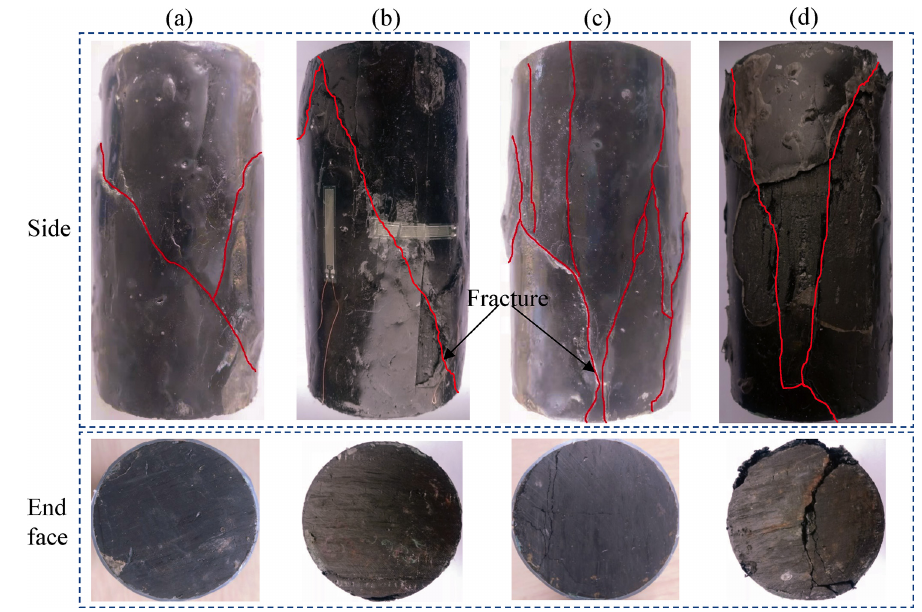
Figure 12. Fracture shapes of specimens. (a, b) Unfrozen specimen. (c, d) Freeze–thawed